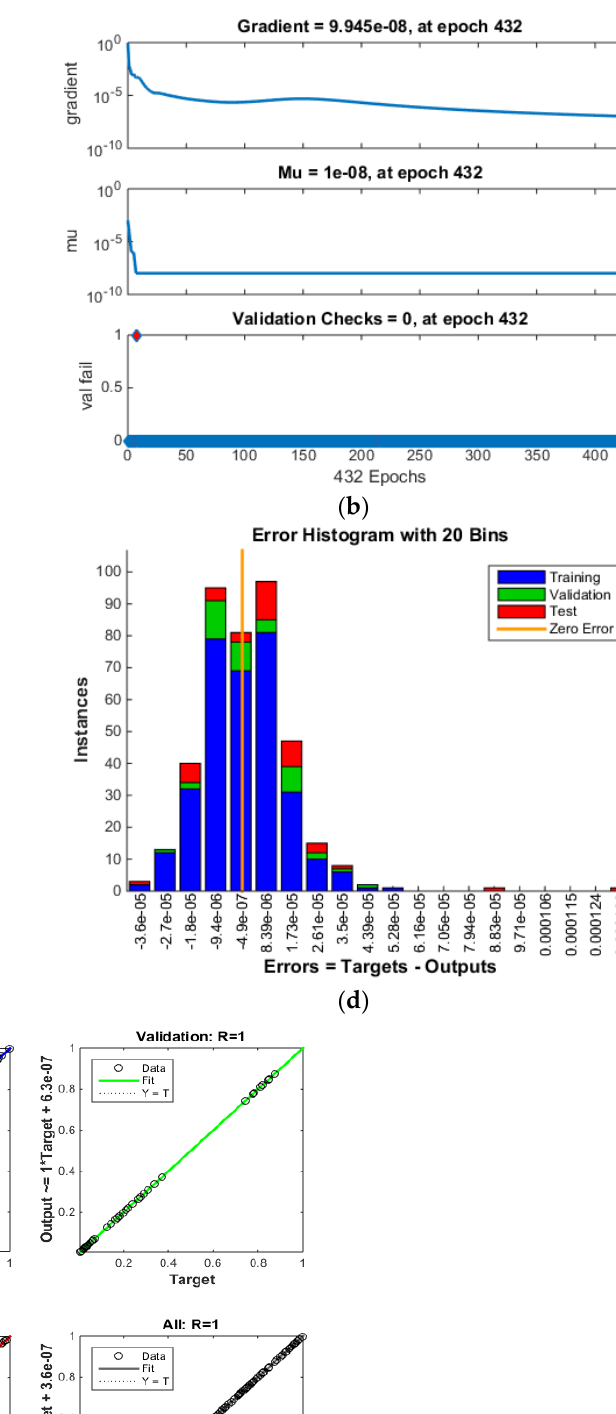
Figure 6. Graphic representation for designed LMT-ABPNN for solving cases of 𝑀𝑎 for 𝑓′(𝜂) of MHD-SGFM. ( a ) MSE Result, ( b ) Results of the transition state, ( c ) Fitness of the curve, ( d ) Histogram for error analysis, ( e ) Regression.